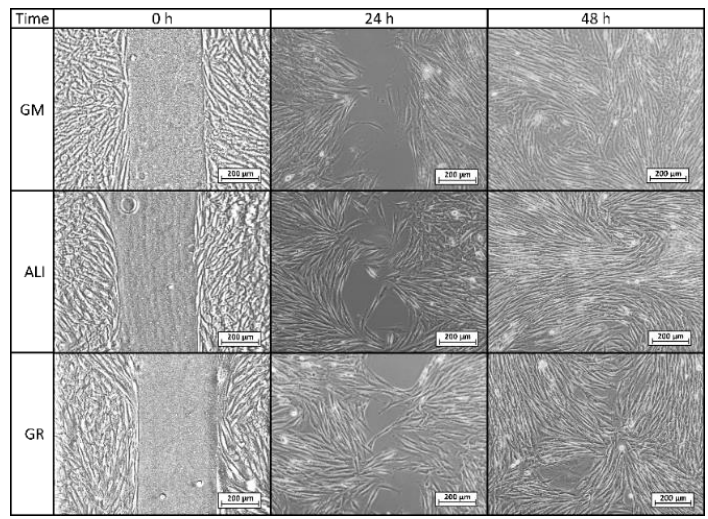
Figure 5. Optical microscopy of wound healing tests for control group (GM) and spring waters (ALI and GR) at 50% ( v/v ) culture concentration.